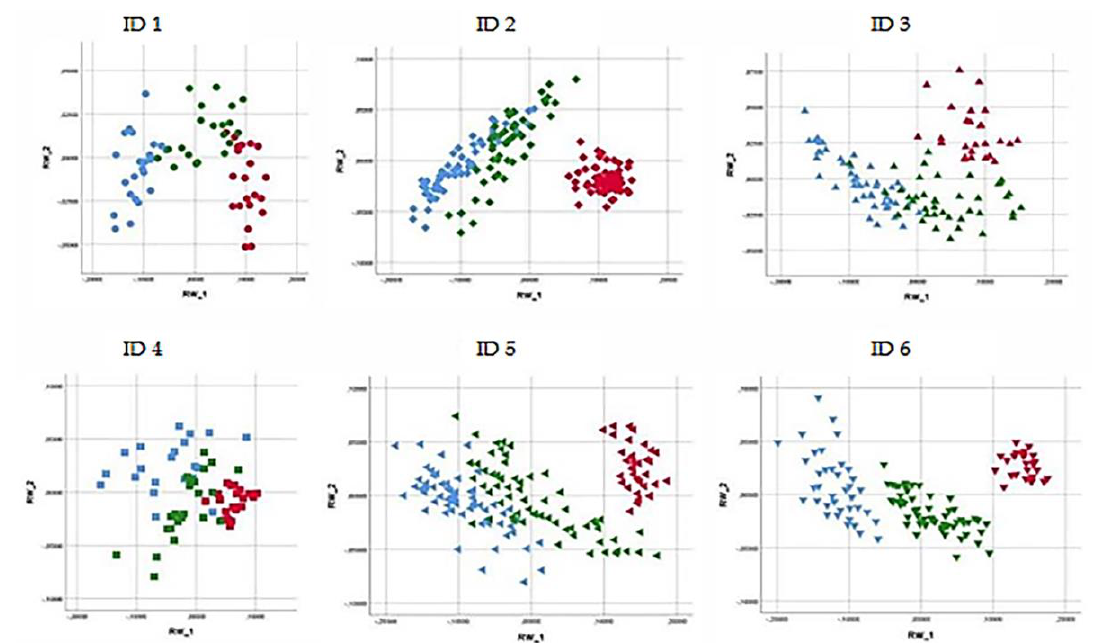
Figure 8. Scatterplot of the first two relative warp scores (RWs) considering the neck posture of the individual horses. The three different colors describe the data obtained for three different feeding positions: red, on the ground—control position (CP); green, neck held 15 ± 3° below withers height with low hay net position (LP); and blue, neck held 15 ± 3° above withers height with high hay net position (HP). Principal component analysis (PCA) based on the first two RWs (RW 1 and RW 2) describes the percentage of the overall shape variation: 96.79% for ID 1; 95.80% for ID 2; 95.25% for ID 3; 90.47% for ID 4; 95.86% for ID 5; and 97.08% for ID 6.